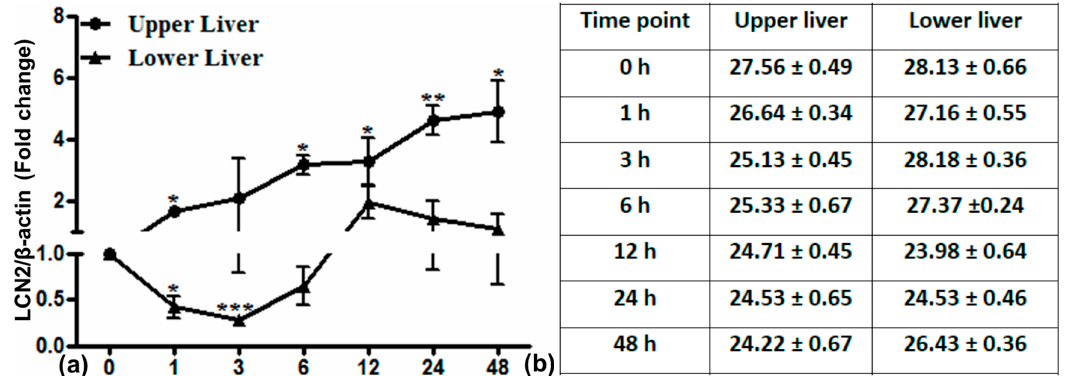
Figure 6. Relative mRNA expression of LCN2 in the upper and lower part of the liver after lung irradiation. Data are given relative to normal sham irradiated control rats ( a ). The results were normalized to β -actin as the housekeeping gene. Experimental errors are depicted as ±SEM (* p ≤ 0.05, ** p ≤ 0.005, *** p ≤ 0.0005, n = 3). Ct values are shown in ( b ).